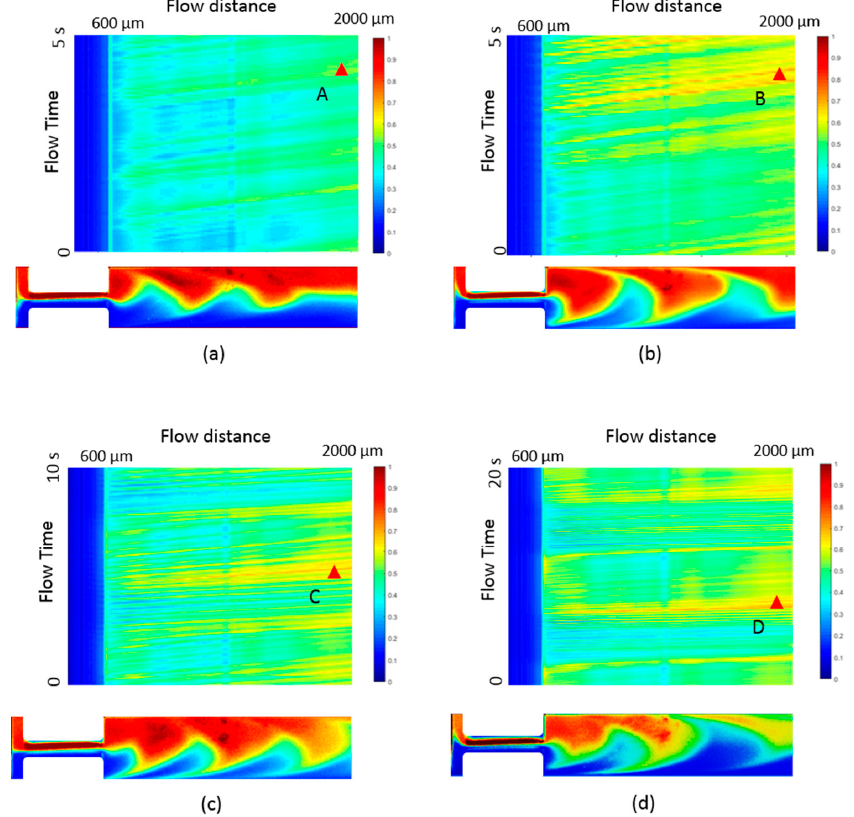
Figure 8. Top: The instantaneous mixing degree along the flow distance at di ff erent flow times with a flow rate of 500 µ L / h at a pulsing frequency of ( a ) 0 ; ( b ) 0.1 Hz; ( c ) 0.2 Hz and ( d ) 1 Hz. Bottom: The concentration profiles at the instance of A, B, C, and D,